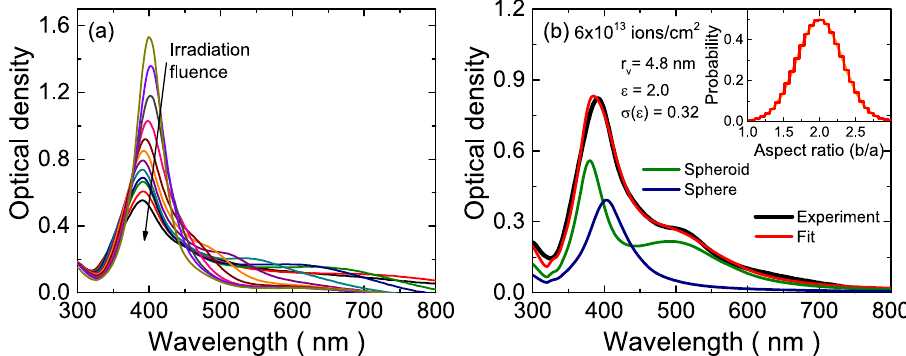
Figure 1. ( a ) Selected experimental optical spectra, illustrating the appearance and evolution of the second LSPR mode upon irradiation. ( b ) Typical fit of an experimental spectrum with the model described in this paper, showing the parameters obtained from the fit ( r V , ε , σ ( ε ) and the contribution of spheroids and spheres to the total optical